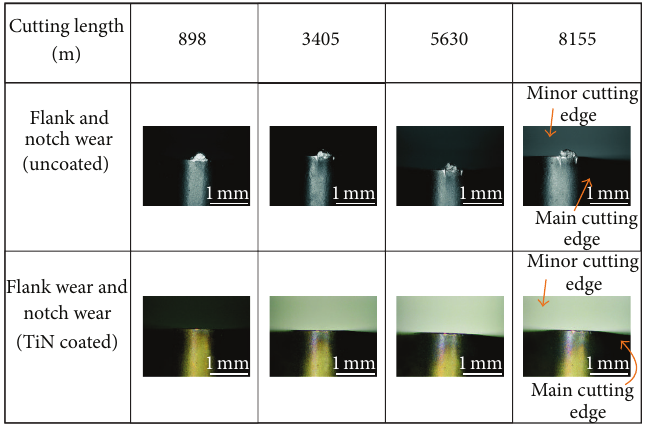
Figure 4: Comparison of wear of uncoated and TiN-coated cutting tools for set of parameter: 𝑣 𝑐 = 100 m/min, 𝑓 = 0.20 mm/rev, and = 0.1 𝑎 𝑝